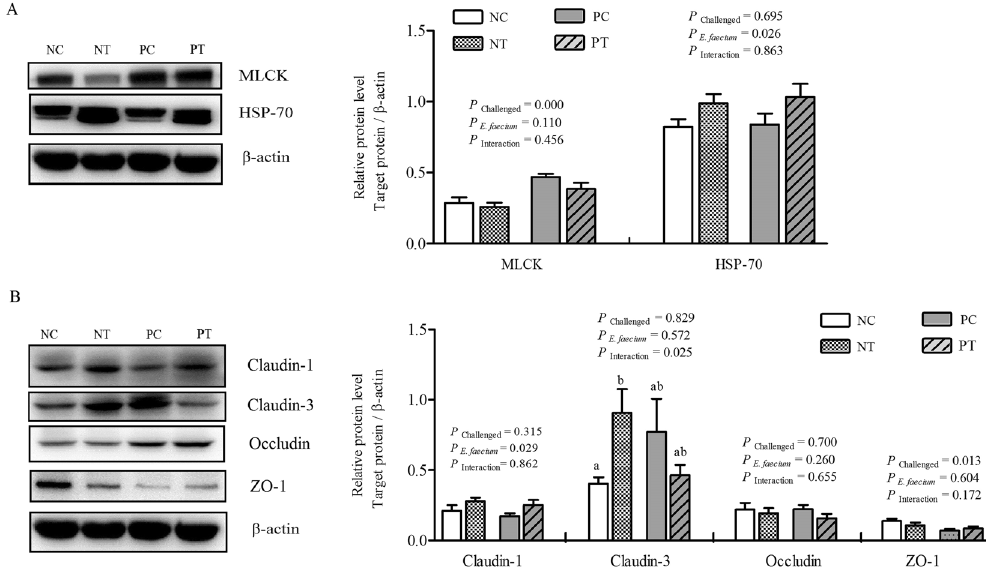
Figure 10. Effect of dietary E . faecium 11181 on tight-junction protein levels in the jejunum of broiler chickens challenged with NE at d 26. ( A ) MLCK and HSP70 ( B ) Claudin-1, Claudin-3, Occludin and ZO-1. Each result represents the mean value ± SEM (n = 6). The lowercase letters on the bars indicate significant differences ( P < 0.05). NC = Non-NE-infected + no E. faecium treatment, NT = non-NE-infected + E. faecium treatment, PC = NE-infected + no E. faecium treatment, PT = NE-infected + E. faecium